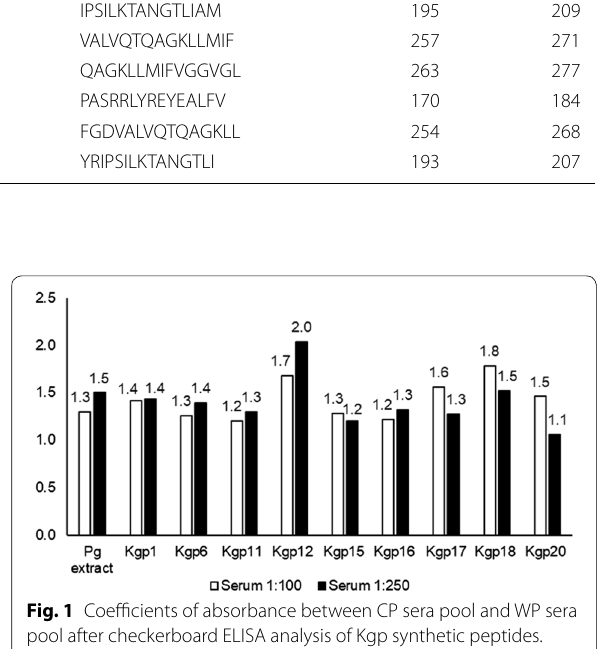
Fig. 1 Coefficients of absorbance between CP sera pool and WP sera pool after checkerboard ELISA analysis of Kgp synthetic peptides. Brazil, 2018. CP: chronic periodontitis; WP: without periodontitis. The coefficient is the difference of the O.D. value between the sera pools, and it expresses the difference of the mean IgG levels between the CP and the WP sera pools. P. gingivalis (Pg) extract and peptides were used as the antigen in the indirect ELISA test. 1:100 and 1:250 serum concentrations are represented. Kgp12 presented a higher coefficient between CP and WP sera pools in 1:250 serum concentration. Checkerboard ELISA best acquired condition: 5 µg/mL Pg extract concentration, 10 µg/mL peptide concentration, 1:250 sera pool concentration and 1:25,000 anti‑human IgG peroxidase conjugate concentration. The nature of the data does not allow statistical analysis between the